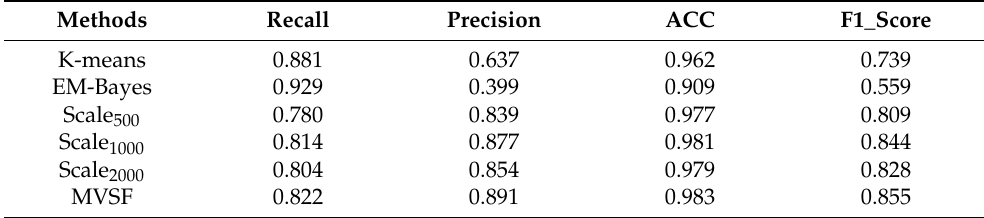
Table 4. Quantitative evaluation of CD results by different methods for Sardinia dataset.